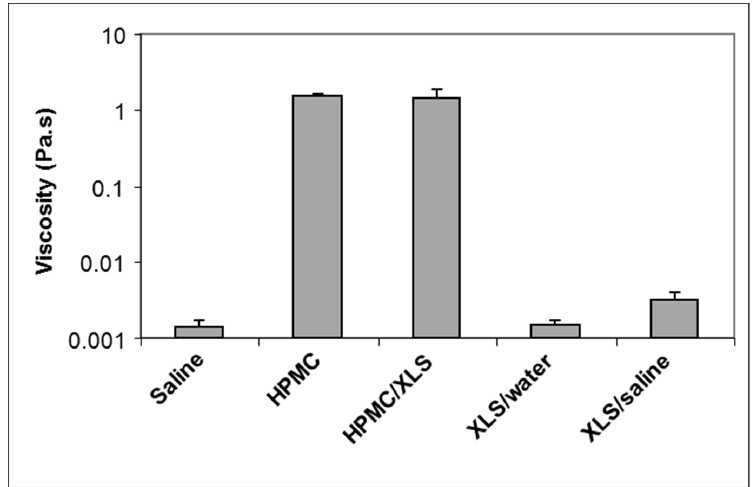
Figure 5. The viscosities of matrices surrounding fluorescent microspheres in different systems. For HPMC/XLS system, matrix means the loose part in dark area. Each data point represents mean ± SEM for n ≥ 3 samples.